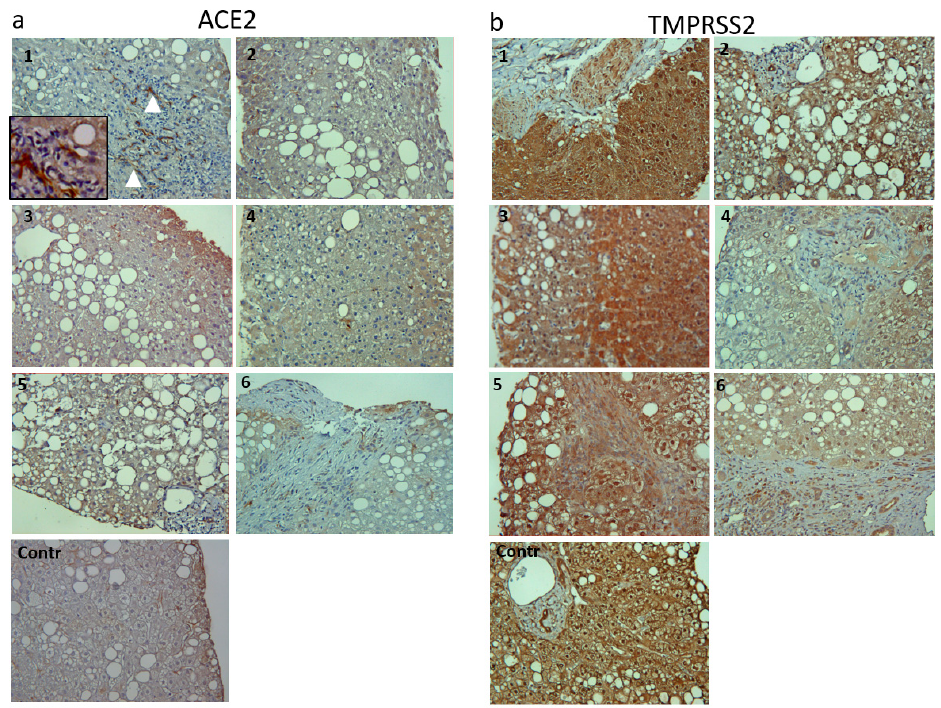
Figure 4. Immunohistochemistry staining for ACE2 (a) and TMPRSS2 (b), images have been taken at 10x magnification. White arrowheads show ACE2 expression in a cirrhotic patient liver. Inset at 20X magnification highlights ACE2-positivity (brown). ACE2, angiotensin converting enzyme 2; Contr, control; TMPRSS2, transmembrane serine pro-tease 2. Cases 1=Cirrhosis; Case 2,3 = F0; cases 4-6 = F3.